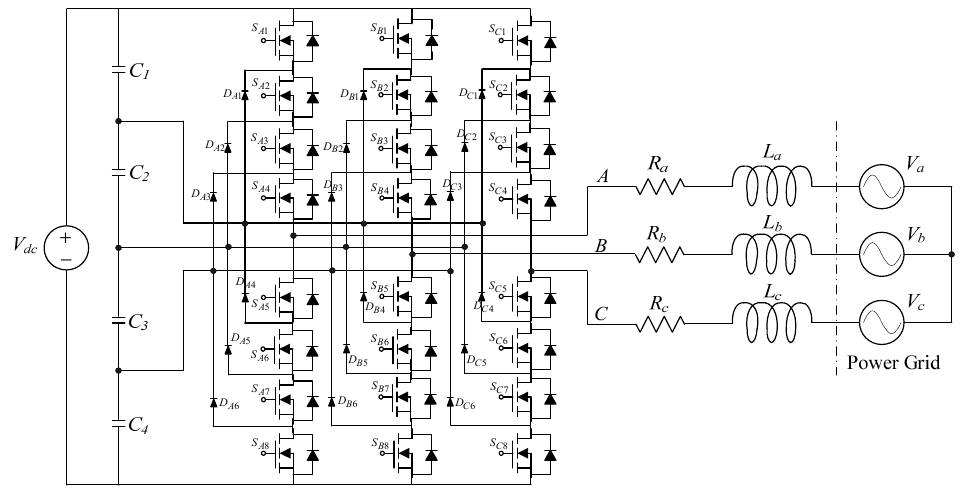
Figure 16. Three-phase neutral-point-clamped five-level inverter using the proposed controller at future research work.